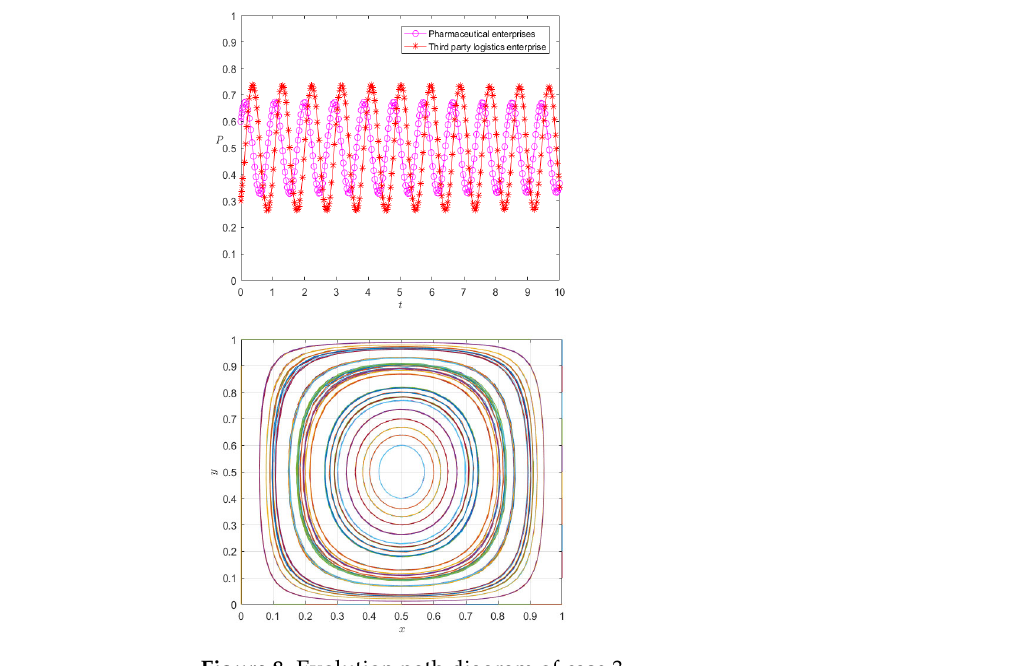
Figure 8. Evolution path diagram of case 3.